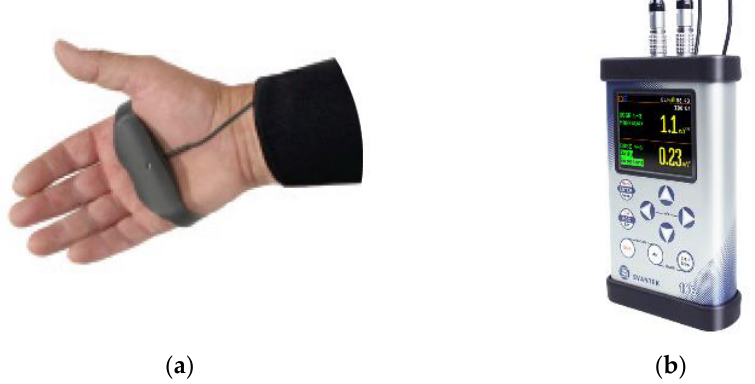
Figure 1. ( a ) Sensor placed on the worker ’ s hand; ( b ) SVAN 106 Four-Channel Sound and Vibration